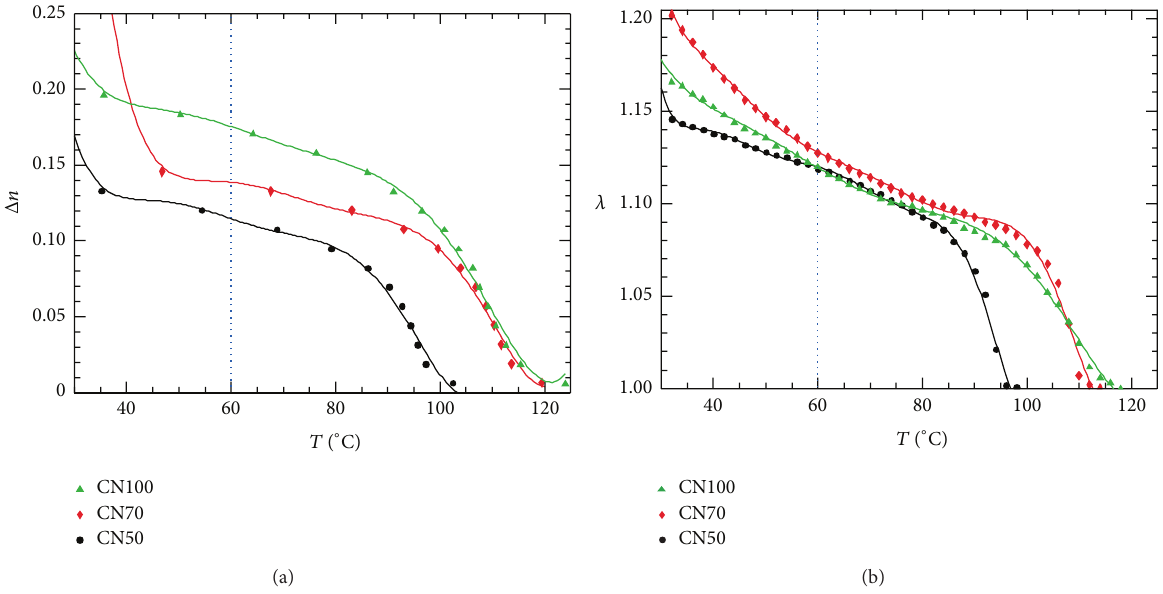
Figure 5: (a) The orientational order parameter measured by birefringence, Δ𝑛 , and (b) spontaneous shape change, 𝜆 , versus 𝑇 ( ∘ C). For 𝑇 > 40 ∘ C, Δ𝑛 shows the least order for the shortest mesogens ∙ CN50 and most for 󳵳 CN100 that with dimers are the longest. X CN70, in the middle, has competing monomeric and dimeric tendencies. For spontaneous shape change, CN70 has the largest 𝜆 and highest 𝑇 𝑔 . The solid curves, 6th order polynomial fits to the data, extrapolated to 0 ∘ C suggest glass transition temperatures, 𝑇 𝑔 ∼ 7 – 10 ∘ C for CN50 and CN100 and about 10K higher for CN70. The dotted line is at 𝑇 ∗ = 60 ∘